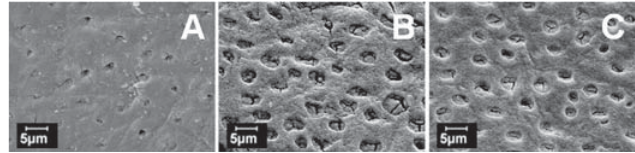
Figure 5- Scanning electron micrographs of sclerotic dentin (A - with no treatment) and after application of adhesive system Adper Scotchbond SE (B-C). In B, sclerotic dentin treated for 20 s and in C, sclerotic dentin treated duplicating